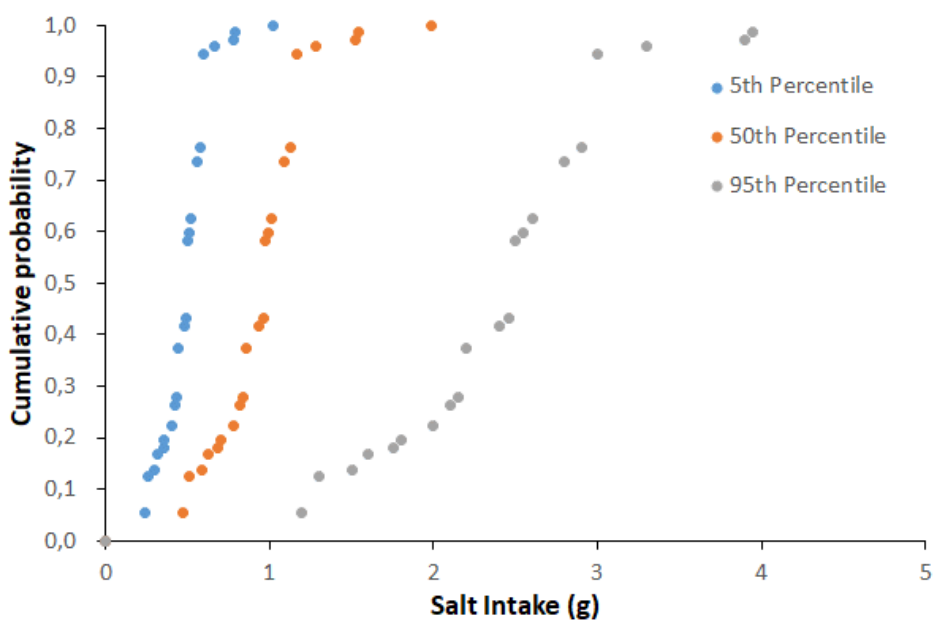
Foods 2020 , 9 , 253 10 of 15 Figure 4. Cumulative probability of salt (g) intake per capita and per day of Greek adults’ consuming feta cheese marketed in the Greek market for the fifth, 50th and 95th percentiles of daily consumption.